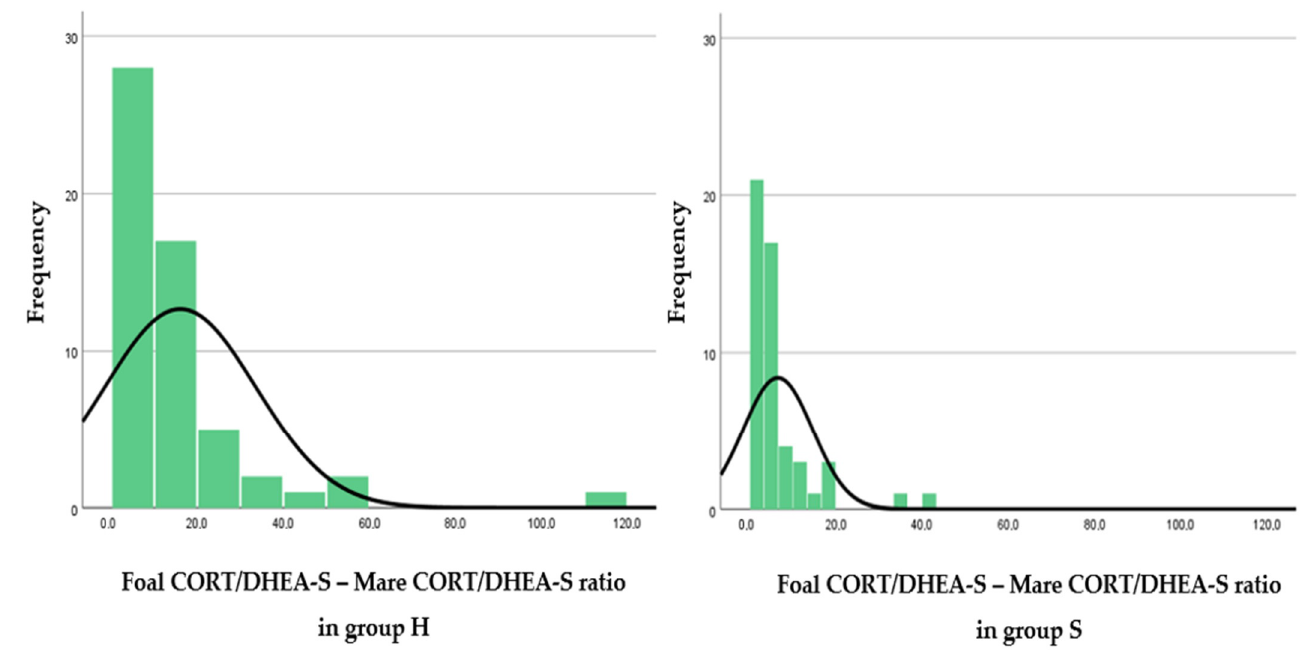
Figure 2. Frequency distribution graphs representing CORT/DHEA-S ratio in mares of the two groups (healthy foals—H, left; sick foals—S, right).